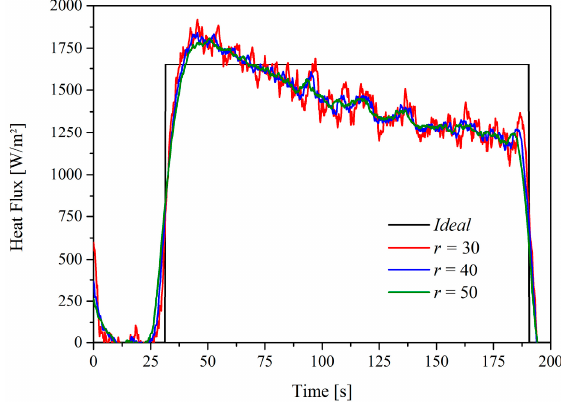
Figure 10. Estimated heat flux for the AISI 304 stainless steel.